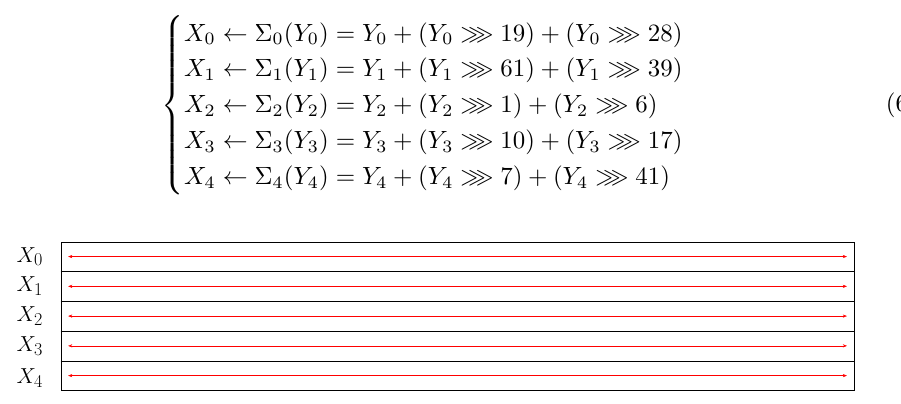
Figure 4: Linear diffusion layer p